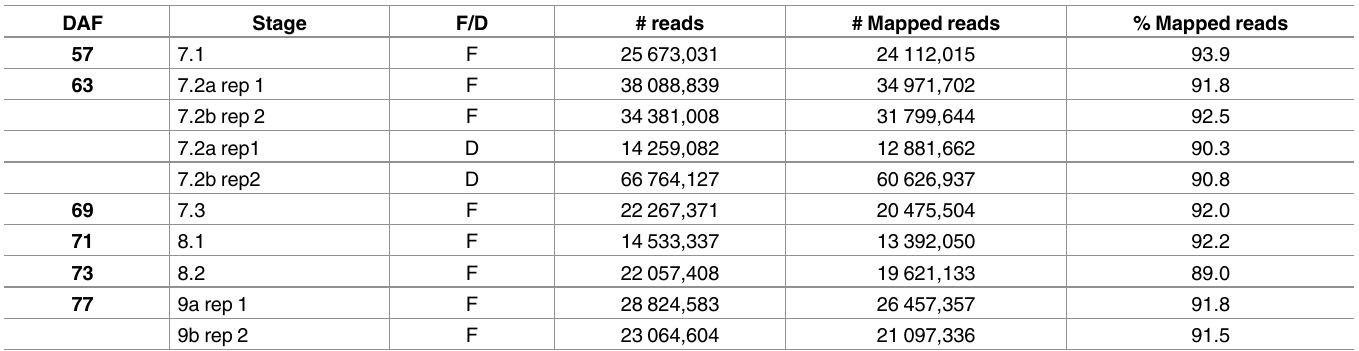
Table 1. Mapping of single-end reads to the soybean genome.